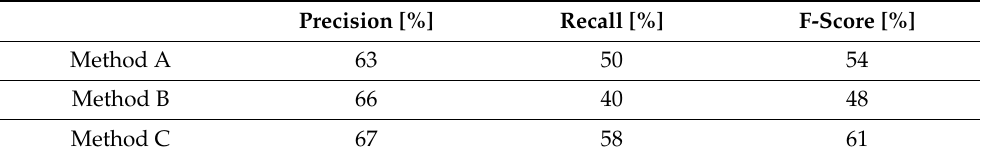
Table 3. Results when the majority answer data are in the top three estimated emotions by Web search. Precision